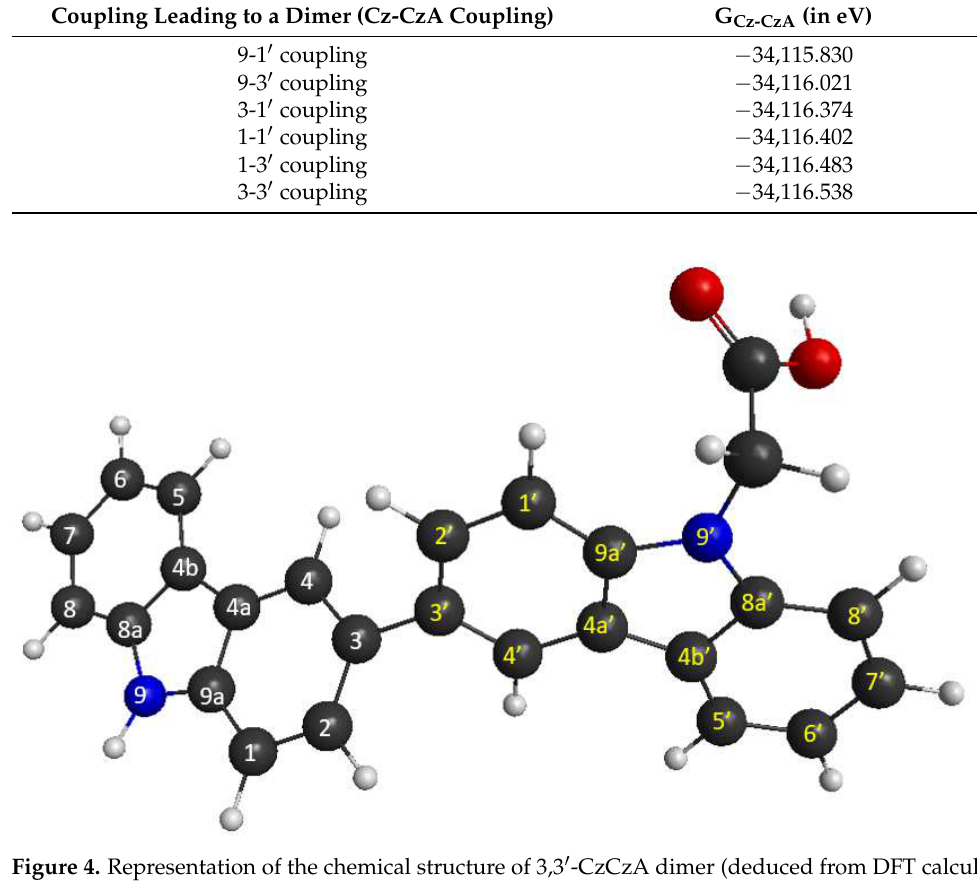
Figure 4. Representation of the chemical structure of 3,3′-CzCzA dimer (deduced from DFT calculations at the B3LYP/6-31G* level of theory).